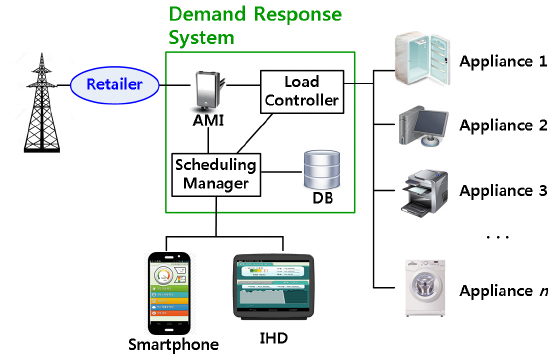
Figure 1. Concept of the proposed smart grid residential system